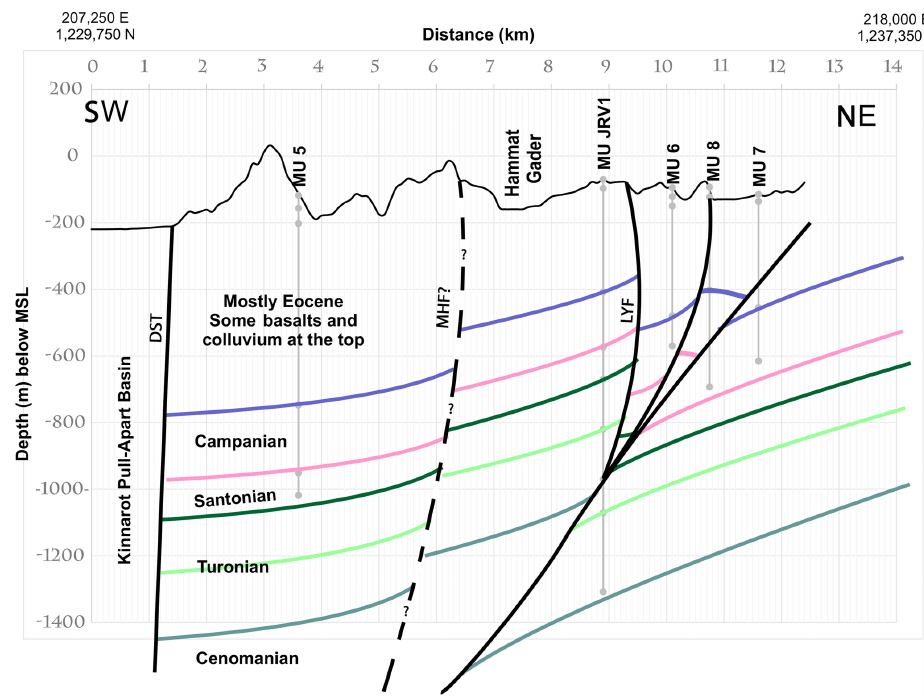
Figure 3. Geotectonic cross section along the Lower Yarmouk Gorge, showing the interpretation of seismic line data and borehole informa- tion, which result in the given faults and depth position of geological